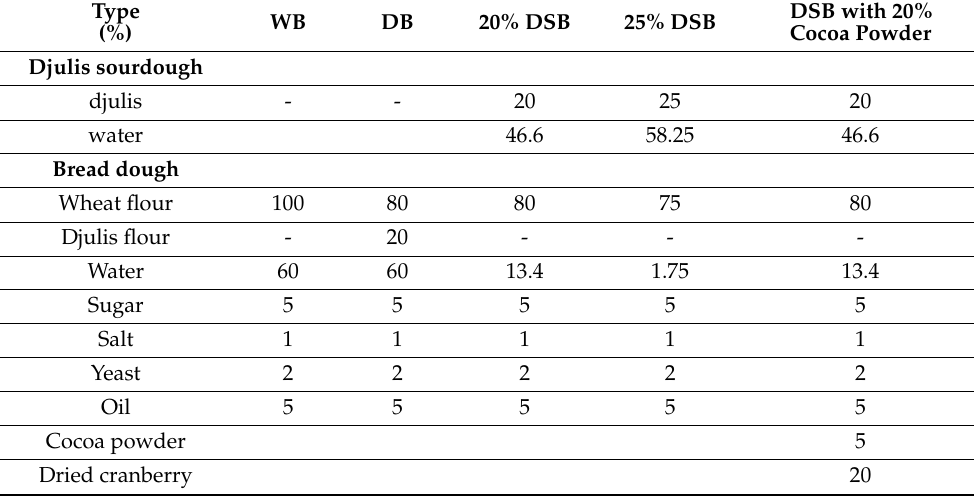
Table 7. Recipe of